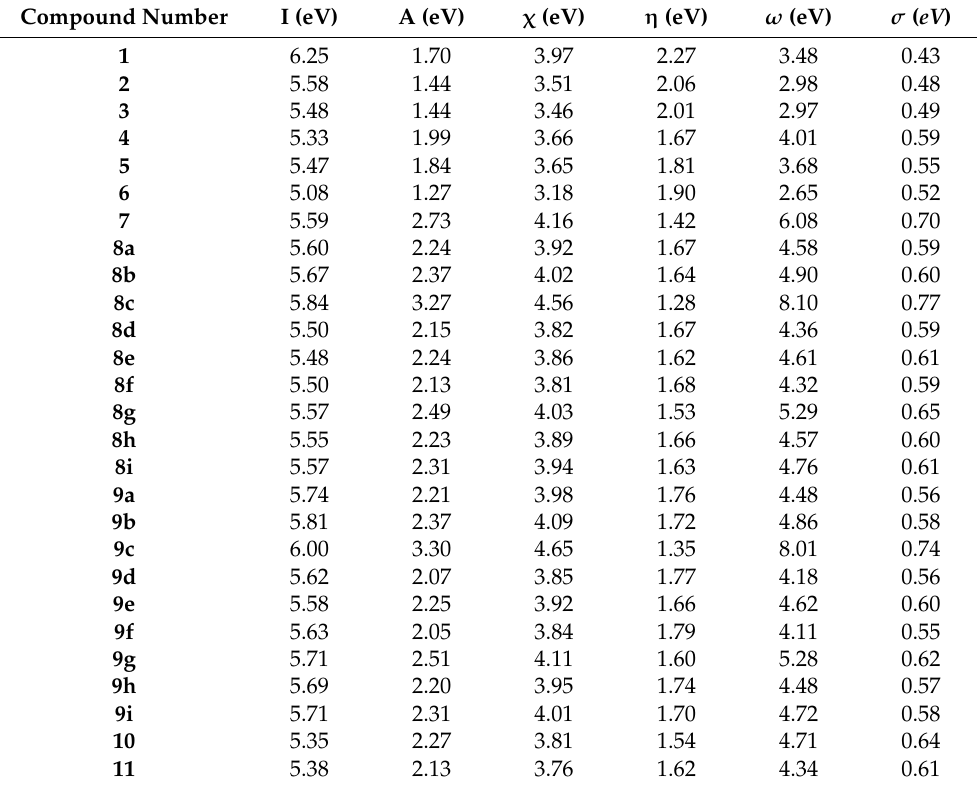
Table 4. Predicted molecular properties of the compounds studied using the DFT method. B3LYP model.6-31G+ basis